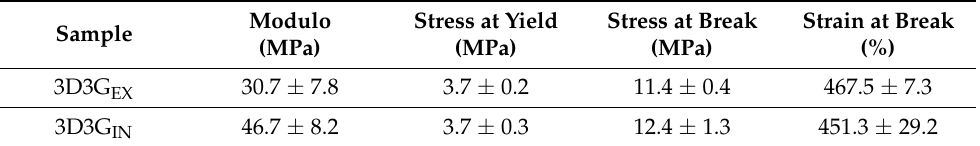
Table 3. Young modulus, stress at yield, stress at break and strain at break values for 3D printed